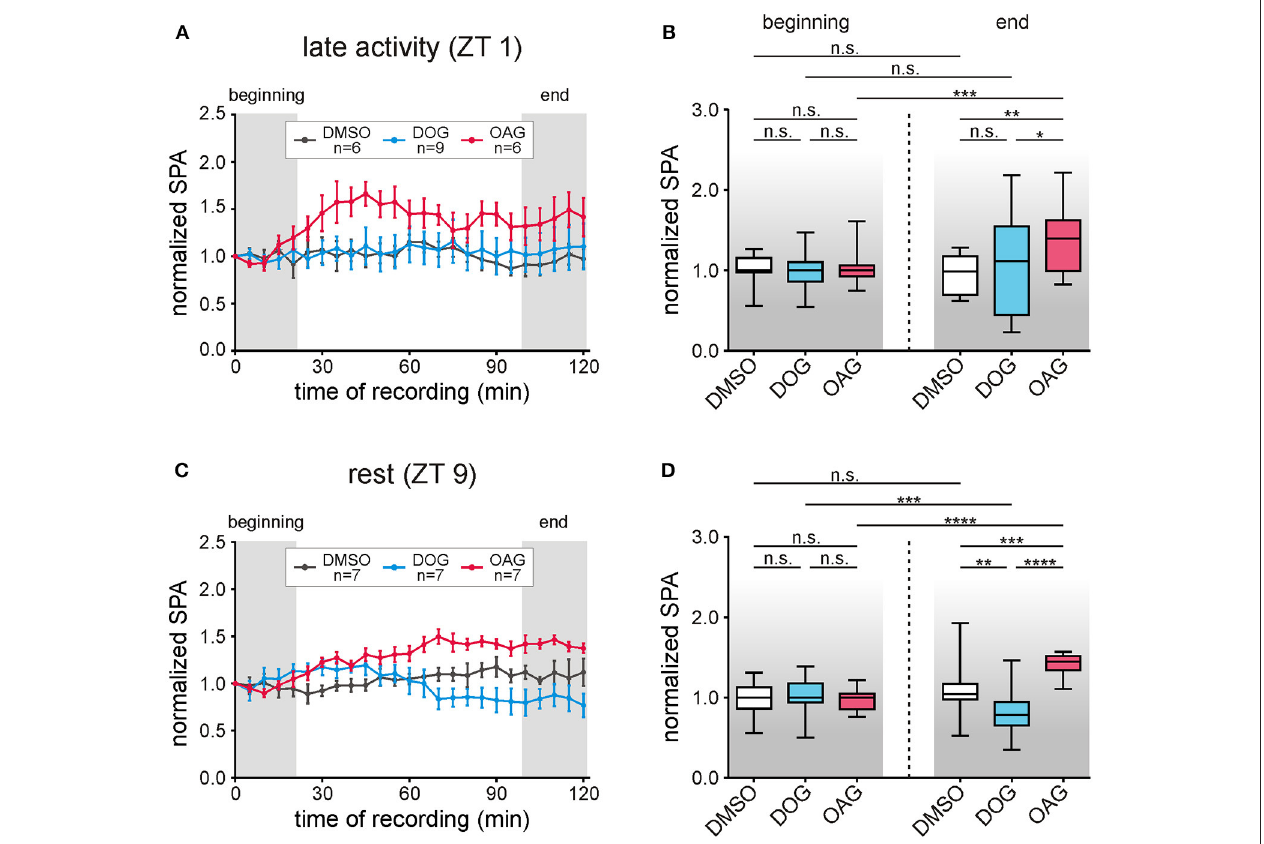
FIGURE 2 | The DAG analog OAG (magenta) increased the bombykal (BAL)-dependent sensillum potential amplitude (SPA) at ZT 1 and ZT 9, while the DAG analog DOG (cyan) decreased it at ZT 9 only. Long-term tip-recordings over 120min were performed from pheromone-sensitive trichoid sensilla on the antenna of the hawkmoth Manduca sexta either during the late activity phase at Zeitgebertime 1 (ZT 1) (A,B) , or during the resting phase at ZT 9 (C,D) . Every 5min 50ms pulses of BAL (1 µ g) were applied. Via the tip-recording electrode either the DAG-analogs OAG (magenta, 100 µ M) or DOG (cyan, 100 µ M) were applied, in comparison to control infusions with vehicle only (Ringer containing 0.1% DMSO, black). The SPA in response to stimulation with BAL was normalized to the value of the first stimulation. Relative changes in the SPA were shown. Statistical analysis was performed during the first and last 20min of the recordings ( Table 1 ; gray areas A,C) . During the late activity phase (ZT 1–3) the normalized SPA was stable for control- and DOG recordings (A,B) . Application of 100 µ M OAG increased the SPA over the course of the recording resulting in significant differences to controls and DOG. (C,D) Also, at ZT 9–11 the SPA remained stable in controls, while DOG decreased-, and OAG significantly increased it over time ( D , exact P -values: Table 1 ). n.s. = not significant; * P < 0.05; ** P < 0.01; *** P < 0.001; **** P < 0.0001; Mann-Whitney test or Kruskal-Wallis test with Dunn’s post-hoc test for multiple comparison. For mean values ± SEM see